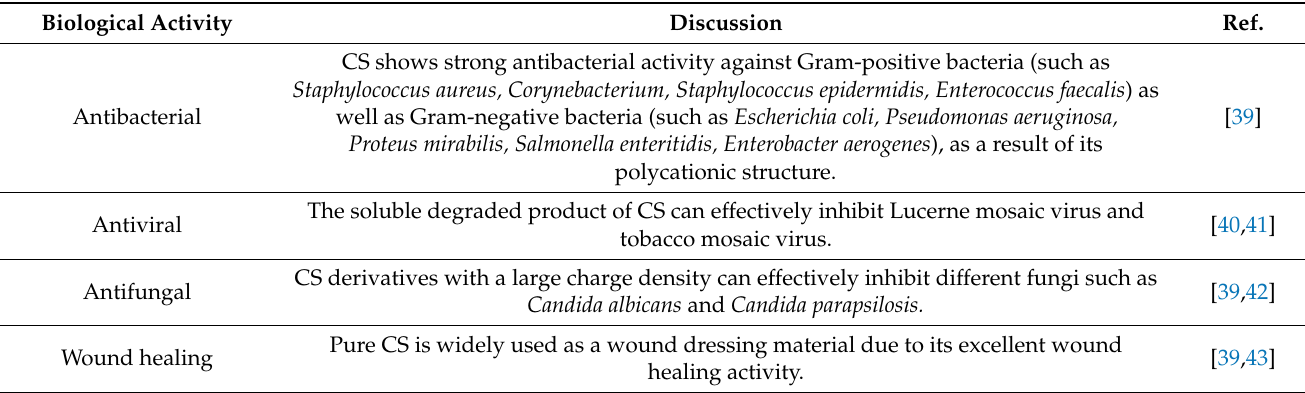
Figure 2. Chemical structure of chitin, chitosan, and protonated chitosan. Table 2. Biological properties of pure chitosan.